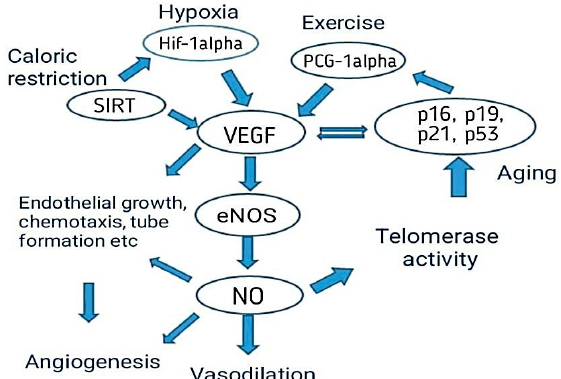
Figure 4. Factors involved in angiogenesis: exercise; hypoxia; caloric restriction; exogenous delivery of VEGF, SIRT, and Hif-alpha, which help in aging reduction [65,66].